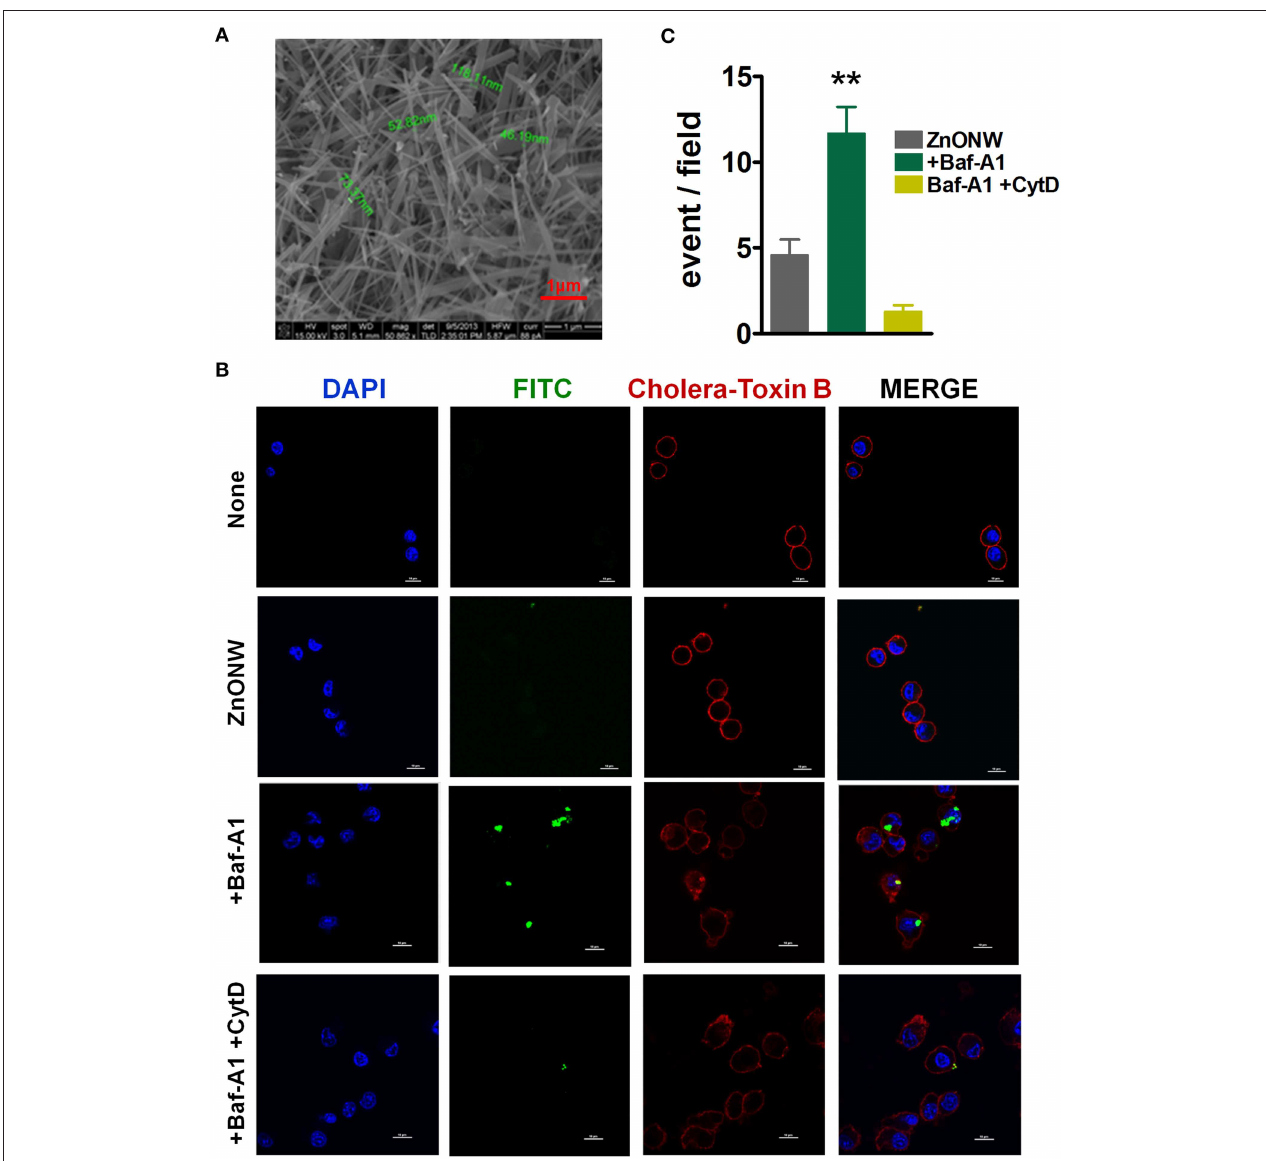
FIGURE 1 | Characterization and cellular uptake of ZnONWs. Scanning Electron Microscopy (SEM) image of ZnONWs indicating size of individual nanowires (A) . LPS-primed BMDMs were stimulated with 25 µ g/ml FITC-ZnONWs for 3h in the presence or absence of Baf-A1 (1 µ g/ml) and CytD (10 µ g/ml). Cells were stained with cholera-toxin B (red) and DAPI (blue) for 20min after fixation and visualized by confocal microscopy (B) . The density of intracellular ZnONWs particles was calculated as number of particle events/ high power field (C) . ** P ≤